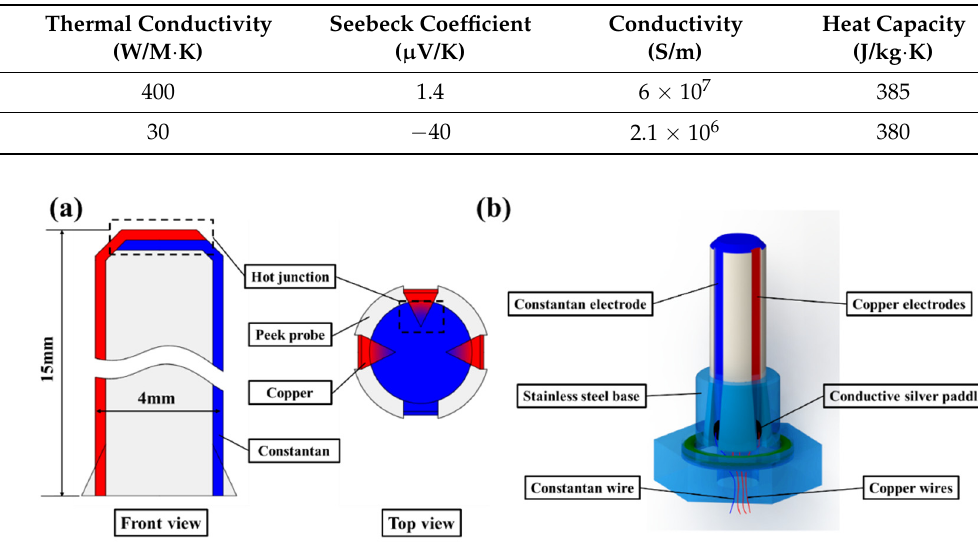
Figure 1. Thermoelectric simulation of the sensor. ( a – c ) The sensor J1 is 200 °C. ( a ) The distribution of temperature. ( b ) Thermoelectric field distribution of the sensor. ( c ) Thermal response curves of the three junctions of the sensor. ( d – f ) The sensors J1~J3 are all 200 °C. ( d ) The distribution of temperature. ( e ) Thermoelectric field distribution of the sensor. ( f ) Thermal response curves of the three junctions of the sensor. Table 1. The key physical parameters of sensor.